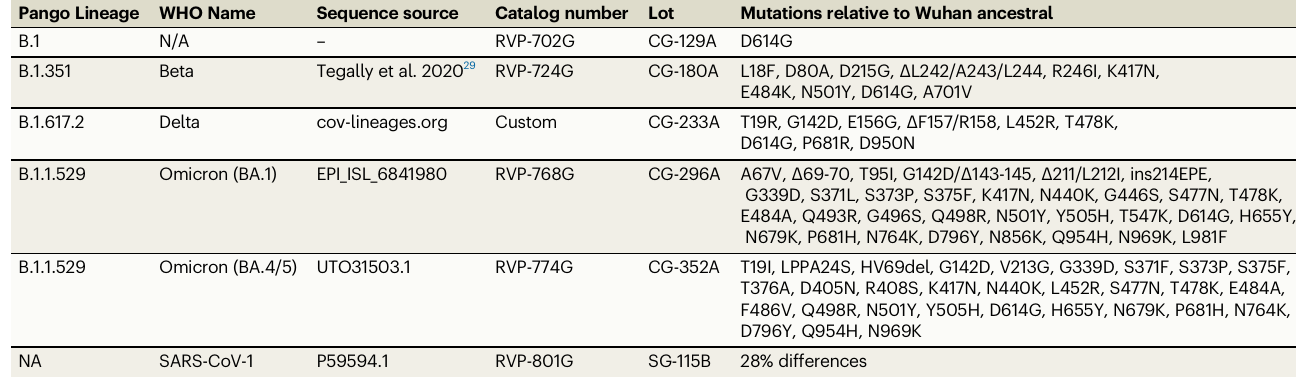
Table 1 | Description of the reporter-virus particles (RVPs) used in the pseudovirus-neutralization assay Pango Lineage WHO